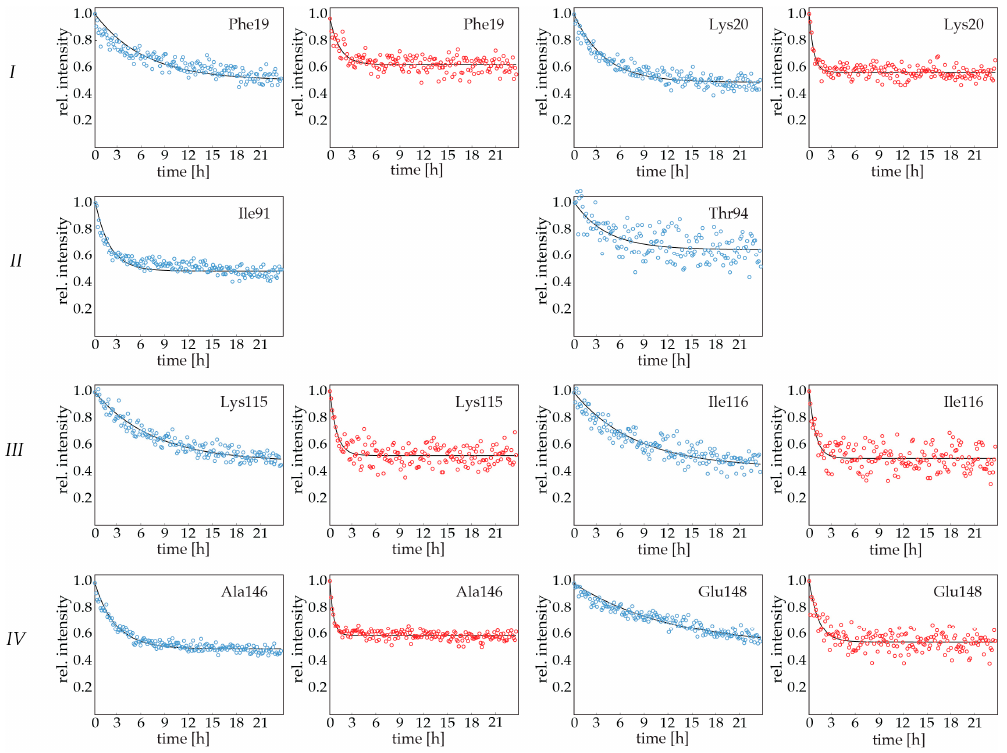
Figure 3. Experimental NMR backbone amide hydrogen-deuterium exchange in Bet v 1 isoforms. Representative SOFAST data for residues in the early proteolytic cleavage sites I – IV ( top to bottom ). Coloring scheme: ( blue ) Bet v 1.0101; ( red ) Bet v 1.0102. Best-fit exponential curves are shown in black. In Bet v 1.0102, experimental data for backbone amides surrounding cleavage site II could not be obtained due to very fast hydrogen-deuterium exchange. Data for both isoforms were recorded at 283 K, pH 8.0.